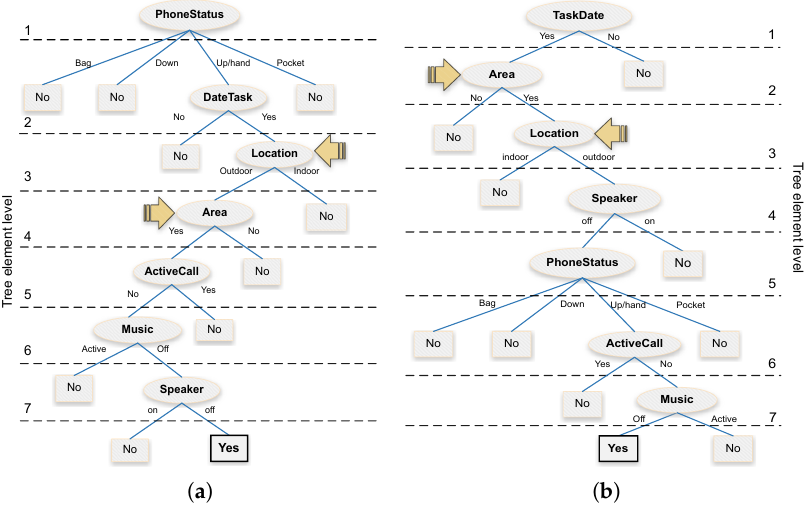
Figure 5. Visualization of the automatically generated trees. ( a ) J48 algorithm; ( b ) Random Tree